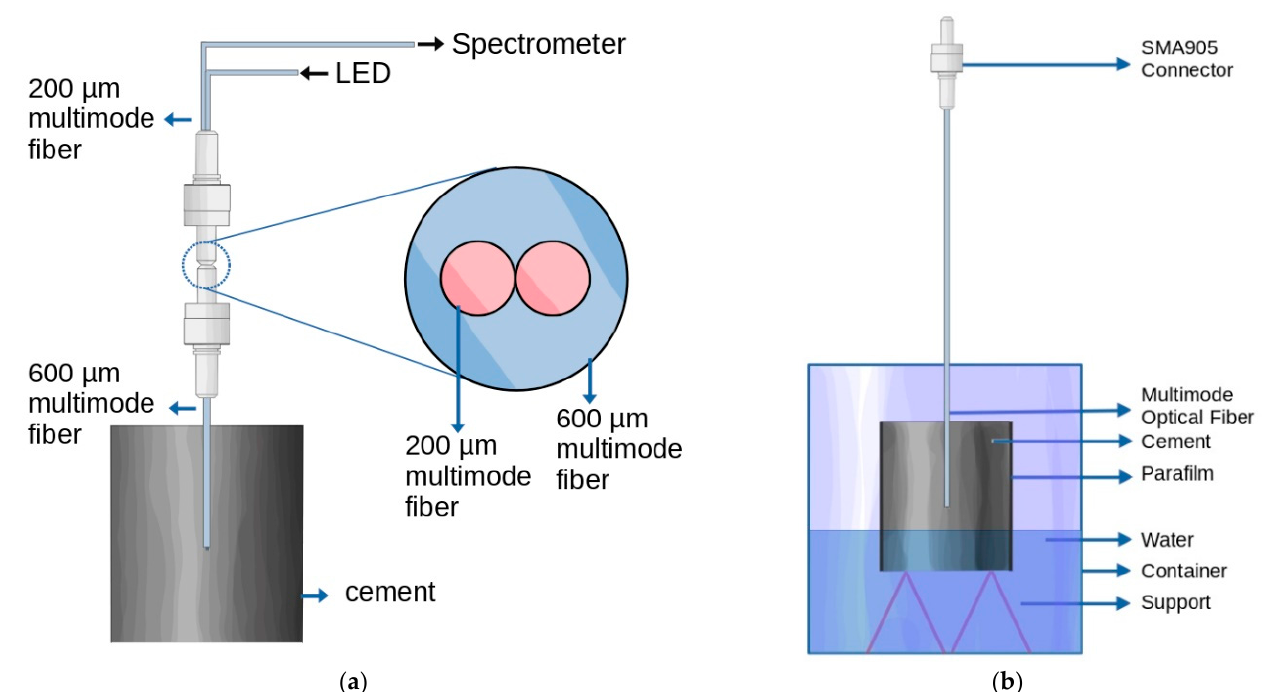
Figure 1. ( a ) Scheme of single fiber reflectance spectrometer embedded in cement paste. Light is emitted from an LED to a 200 μ m multimode fiber, travels to a sensing 600 μ m multimode fiber, where it is reflected at the fiber tip into a 200 μ m multimode fiber and acquired by a spectrometer. ( b ) Sorptivity test with part of concrete sample submerged underwater with its sides covered with parafilm. The bottom face of the sample is in contact with water and the top is exposed to air. The SMA905 connector is shown, but it is not used; only the weight of the sample is measured.